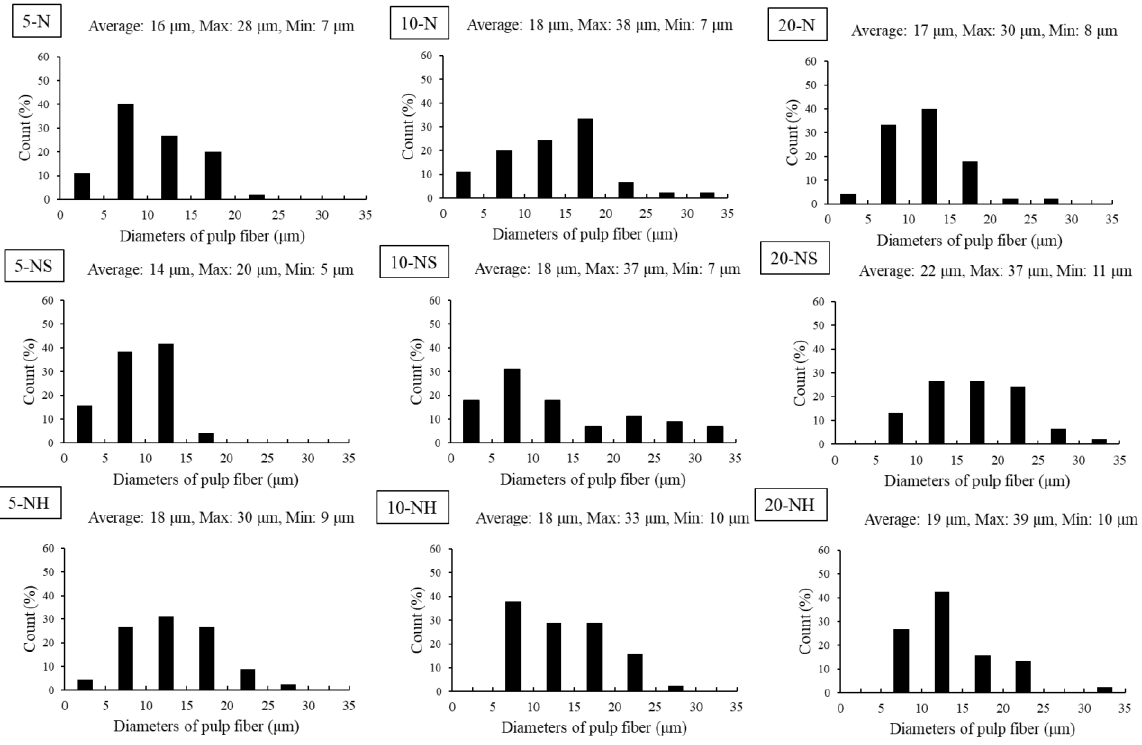
Figure 5. Diameter distribution of Rhizoclonium pulp fibers under different cooking treatments in handsheets. The distribution was measured using 80 individual fibers at 100× magnification.